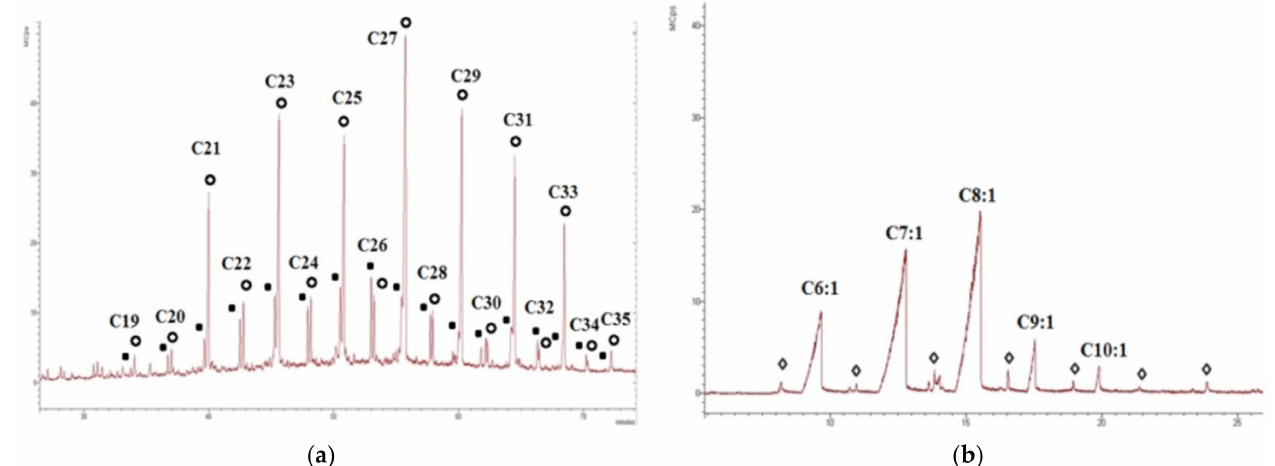
Figure 9. Chromatograms of the aliphatic and polar fractions of the sample “21.5”: ( a ) The distribution of n-alkanes and n-alkenes in the aliphatic fraction ( m/z 57), where black dots denote alkenes, open circles denote alkanes); ( b ) the distribution of monounsaturated fatty acids ( m/z 73) in the polar fraction, where open rhombuses indicate the saturated fatty acids. Table 2. The concentrations of the identified components, and biomarker ratios according to the results of GC-MS analysis. Parameter